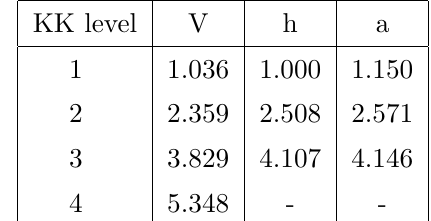
Table 3 . Masses of the lightest gauge and scalar KK states in units of m h considered in the text.